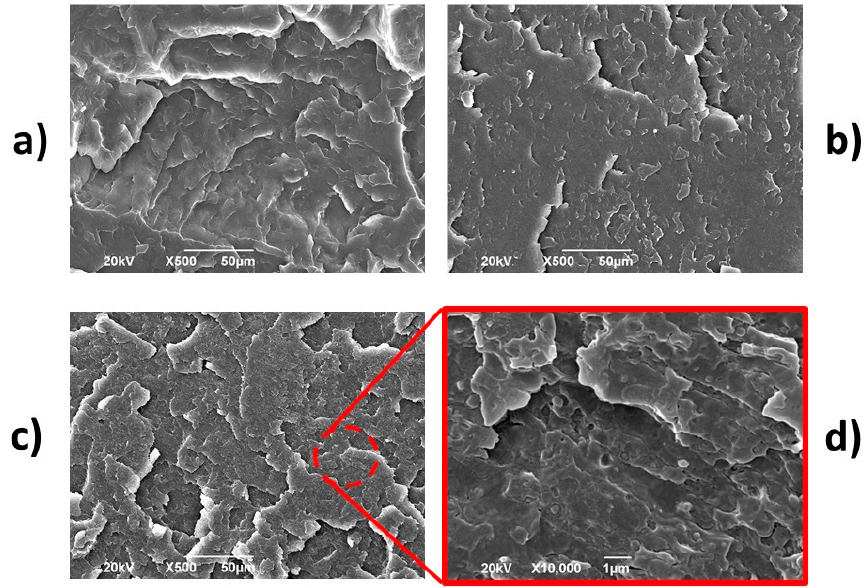
Figure 13. SEM micrographs for ( a ) PP, ( b ) HDPE and PP-HDPE blend ( c , d ).